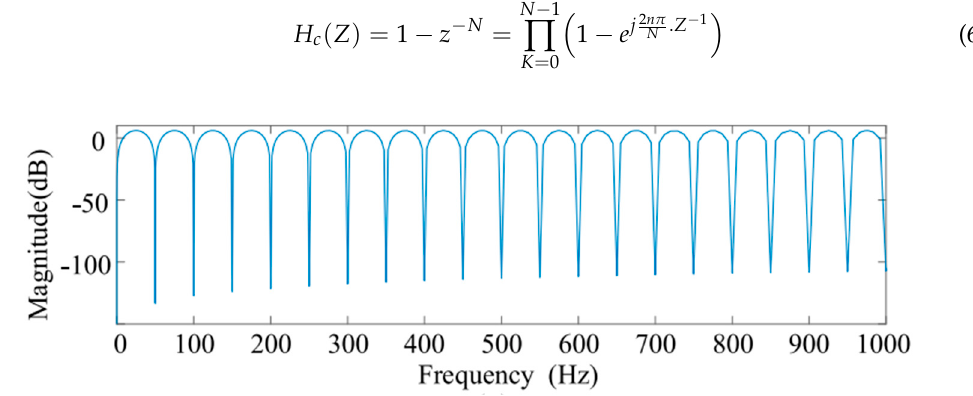
Figure 13. Bode diagram of traditional SDFT.